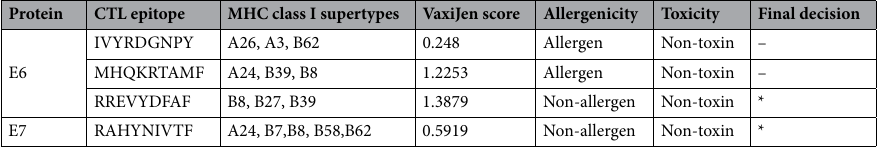
Table 1. Predicted CTL epitopes of E6 and E7